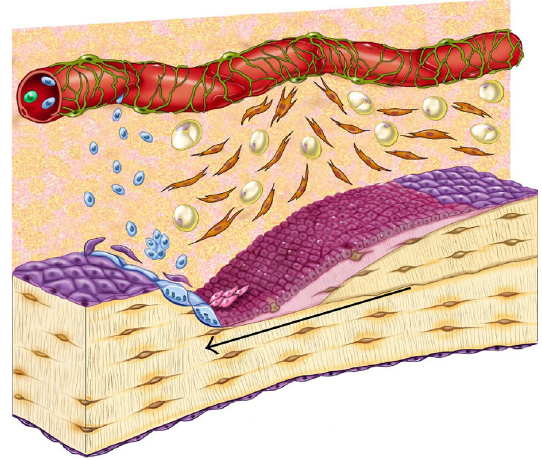
Figure 3. Schematic diagram of the osteoblastic stem cell sys- tem. This conceptual drawing illustrates the primary candidate populations of stem cells and transit cells thought to be asso- ciated with bone formation and remodeling. Vascular pericytes (green), Westen-Bainton cells (orange), type I or pre-osteoblasts (pink), secretory osteoblasts (maroon), osteocytes (brown), lin- ing cells (purple), and adipocytes (yellow). Vascular pericytes may give rise to the Westen-Bainton cells. Pericytes and Westen- Bainton cells may contribute to the formation of pre-osteoblasts and also adipocytes. New osteoblast are added in the region im- mediately behind the advancing front of osteoclastic resorption. Secretory osteoblasts produce new bone matrix until they be- come quiescent on the surface of bone as a lining cells (purple) or become embedded in the matrix as osteocytes (brown), or die via apoptosis. Osteoclast formation is also illustrated. A frac- tion of the monocytes population in systemic circulation (blue) will become resident in the bone marrow space. Osteoclasts are formed by fusion of monocytes resident in bone marrow to form multinucleated functional units. The nuclei in active osteoclasts continue to be turned over as a result of nuclear loss and on- going fusion events with new marrow-derived monocytes [103]. The black arrow indicates the direction of bone resorption by the osteoclastic front, followed by bone